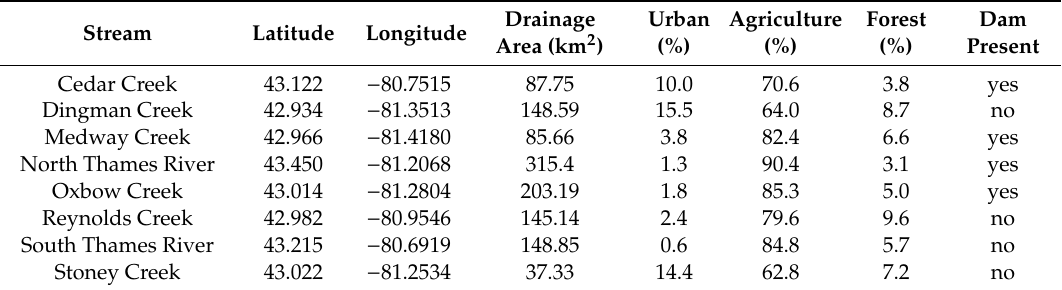
Table 1. Sampling location and landscape characteristics (drainage area, land cover, dam presence) for eight streams located in the Upper Thames River Basin of southern Ontario, Canada. Subwatershed characteristics drawn from Maaskant and Quinlan (2007). North Thames River includes both Whirl and North Mitchell